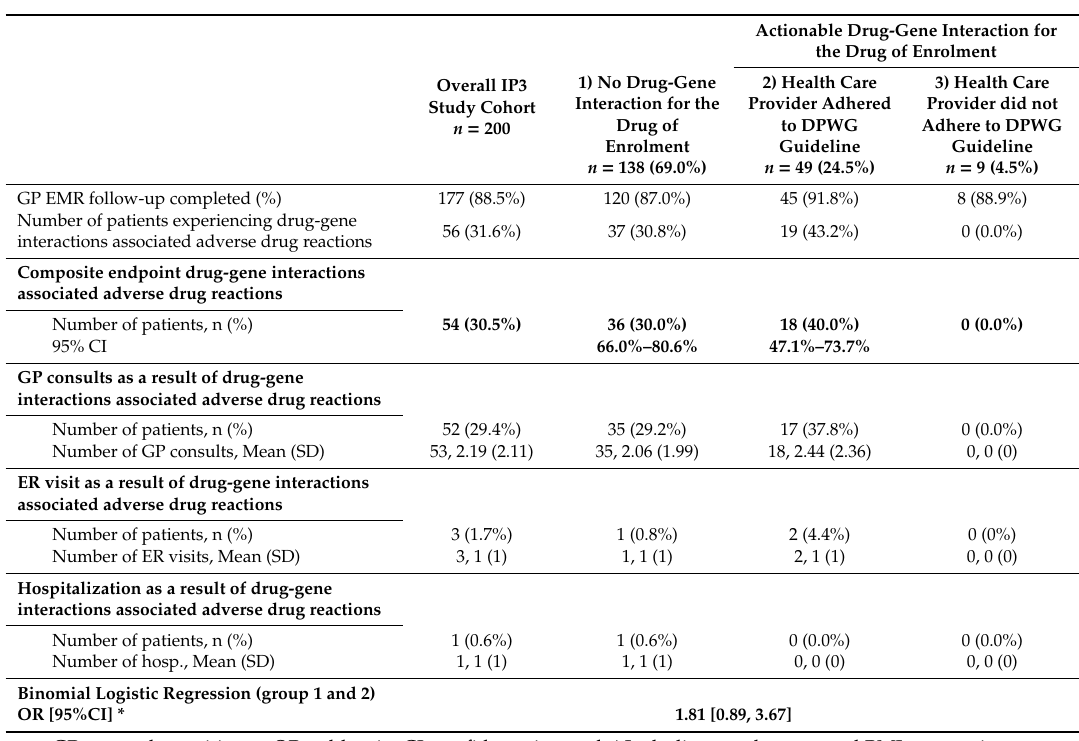
Table 4. Healthcare utilization as a result of drug-gene interaction associated adverse drug reactions within 12 weeks of